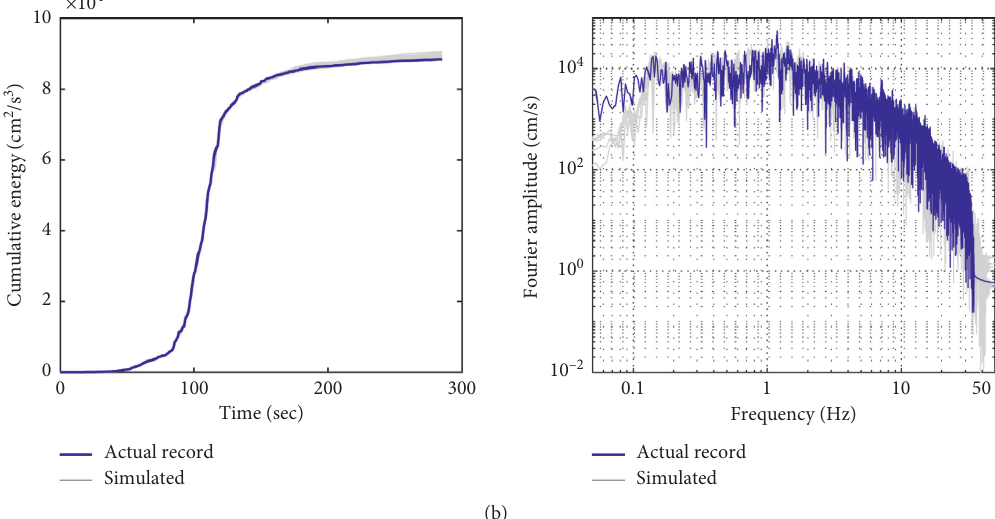
Figure 21: Comparison between four realizations and the recorded motions in terms of Fourier amplitudes and cumulative energy. (a) CHB002EW and (b)